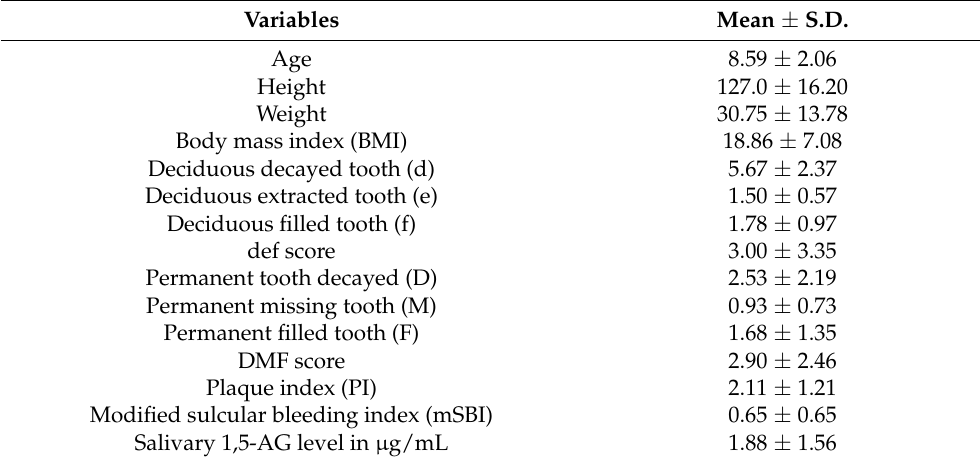
Table 1. Details of the study sample.